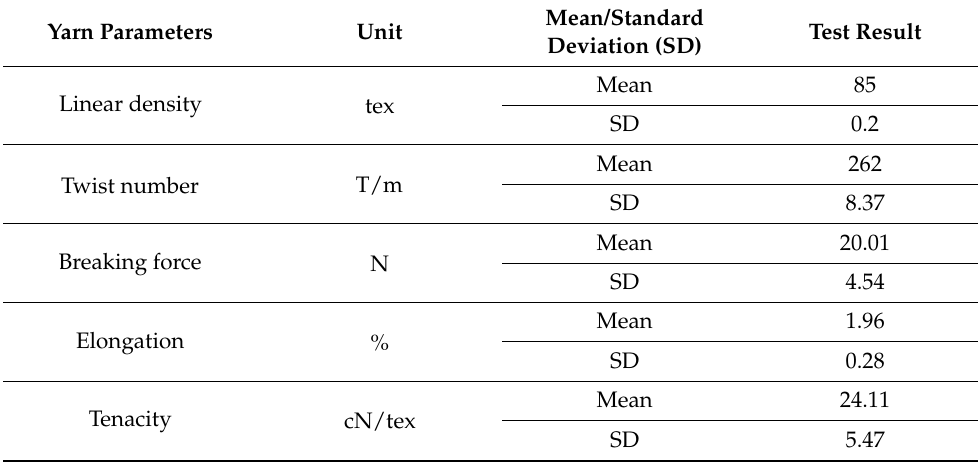
Table 3. The hemp yarn parameters. Yarn